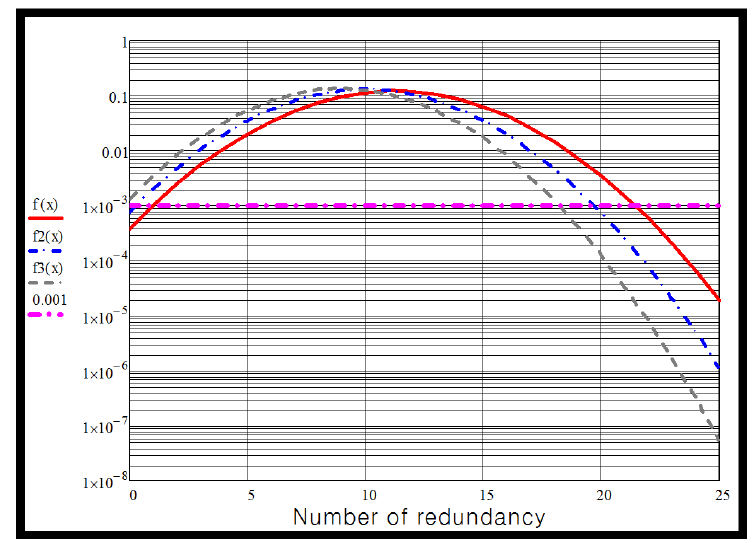
Figure 6. Unavailability function for MMC valve in case of 2-year maintenance.